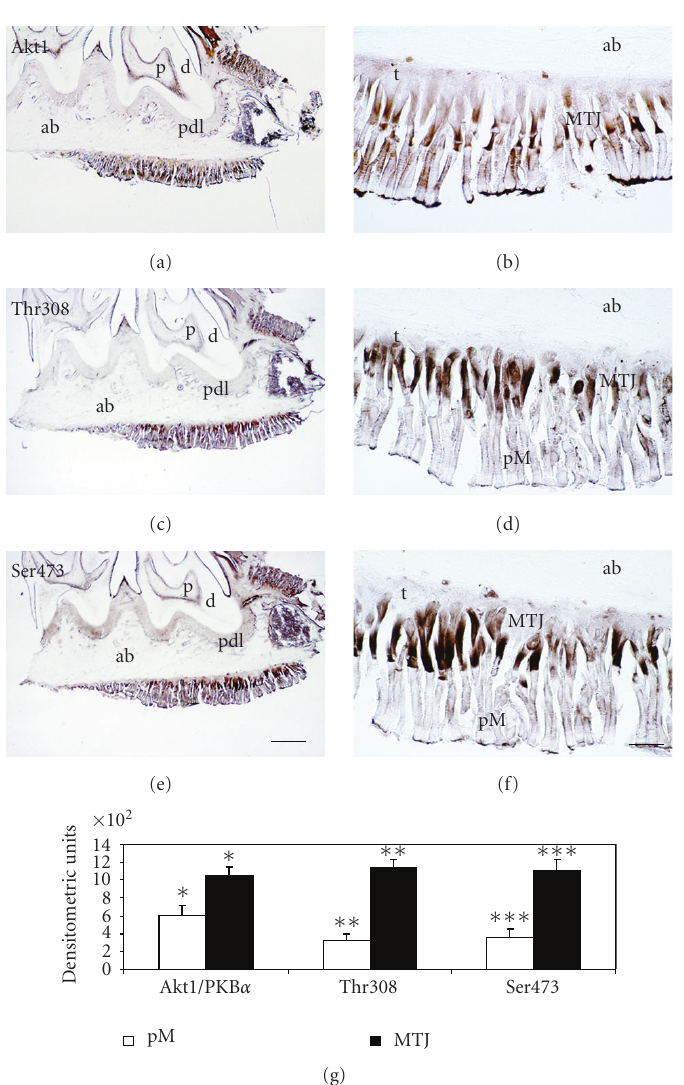
Figure 1: The constitutive localization of the t-Akt1/PKB α , phosphorylation of t-Akt1/PKB α at Thr308 and at Ser473 in muscle fibers within muscle-tendon-bone unit. In comparison to the staining of t-Akt1/PKB α (a, b), p-Akt1/PKB α Thr308 (c, d) and Ser473 (e, f) in the peripheral muscle fibers, t-Akt1/PKB α (b, MTJ), phosphorylation of Akt1/PKB α at Thr308 (d, MTJ) and at Ser473 (f, MTJ) were detected with higher staining intensities in muscle fibers at the myotendinous junction (MTJ) area. The staining intensity of Akt1/PKB α in peripheral muscle fibers (b, 602.70 ± 117.05) was weakly compared to those in the area near to the MTJ (b, 1050.63 ± 91.68). In comparison to the staining intensity of the p-Akt1/PKB α Thr308 in peripheral muscle fibers (d, 319.76 ± 74.57), the staining intensity of p-Akt1/PKB α Thr308 was higher in muscle fibers near to the MTJ areas (d, 1138.85 ± 98.99). The staining intensity of p-Akt1/PKB α Ser473 in muscle fibers at the MTJ areas (f, 351.65 ± 104.63) was greater than staining intensity of Ser473 in peripheral muscle areas (f, 1099.70 ± 135.93). Data are mean ± SD; n = 6; significant di ff erences were considered at a P value < . 05. MTJ = myotendinous junction, pM = peripheral muscle fibers, ab = alveolar bone, pdl = periodontal ligament, p = pulpa, d = dentin. Bars: 640 μ m for (a), (c), (e), 80 μ m for (b), (d), and (f).